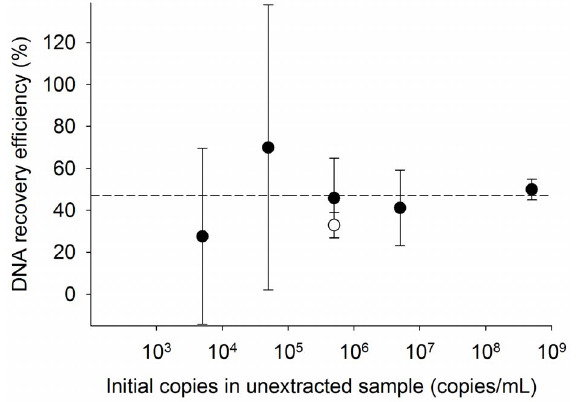
Figure 5. The recovery efficiency of DNA from human urine samples using magnetic bead-based extraction does not change as the number of copies spiked into the 1 mL human urine sample is increased (mean 6 s.d., n=3). The average DNA recovery efficiency of the magnetic bead-based extraction method is shown as a dotted line. The recovery efficiency of the Norgen kit is shown at an initial DNA concentration of 5 6 10 5 copies/mL (white